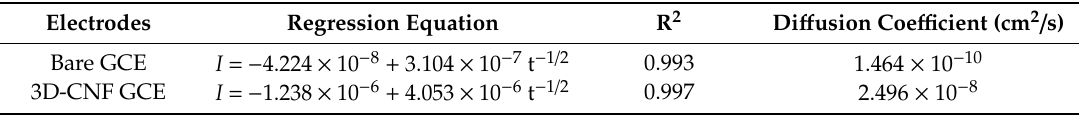
Table 1. Di ff usion coe ffi cient of difenidol on di ff erent